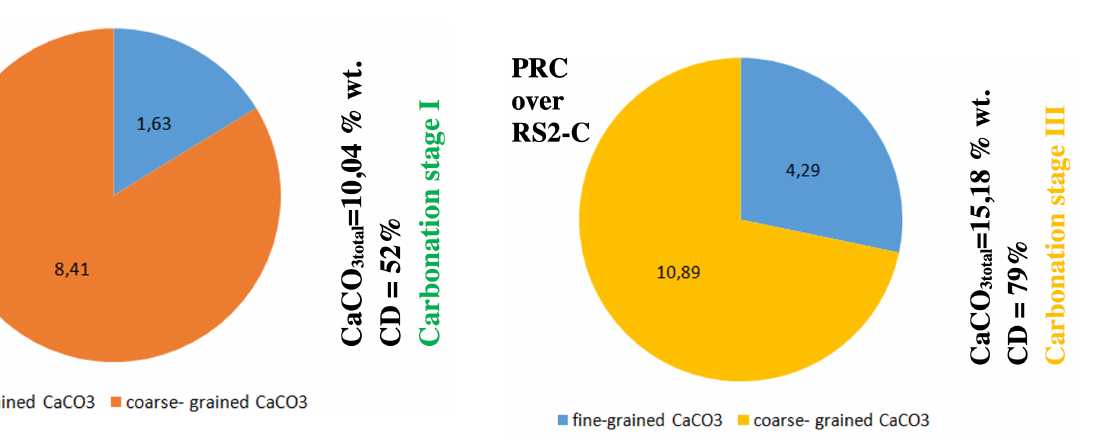
Figure 11. The amount of CaCO 3 (% wt.) in the internal layer of the protected concrete sample RS2-C by PRC.